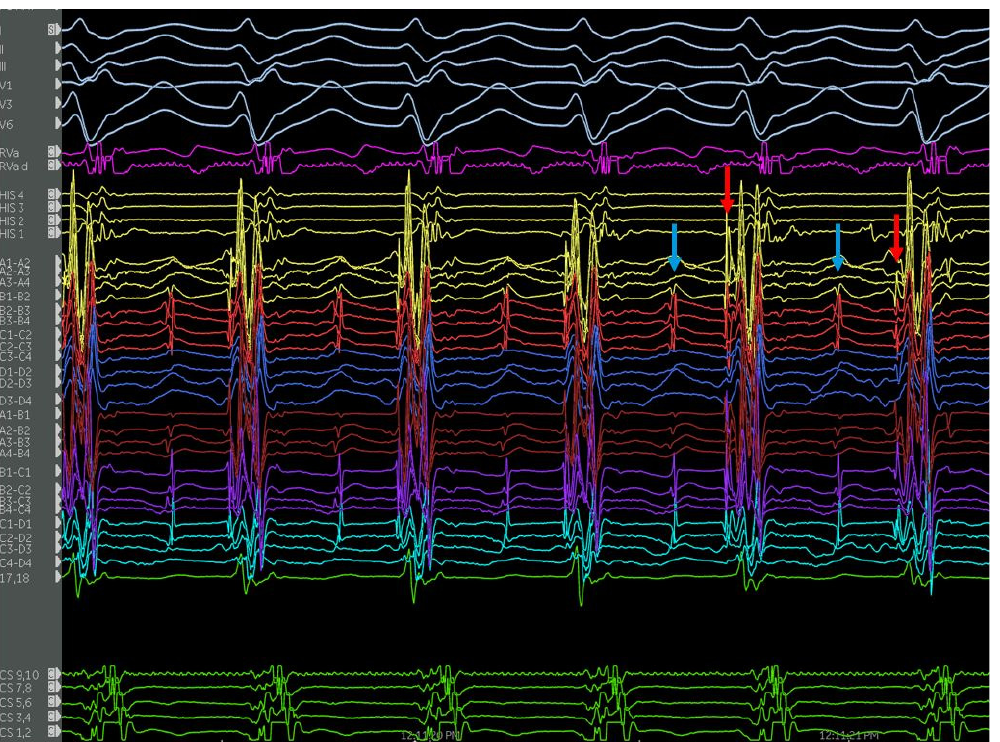
Figure 11. Endocardial signals of IL-VT showing typical pre-systolic signals. Blue arrows denote the P1 signal and red arrows denote the P2 signal during tachycardia.